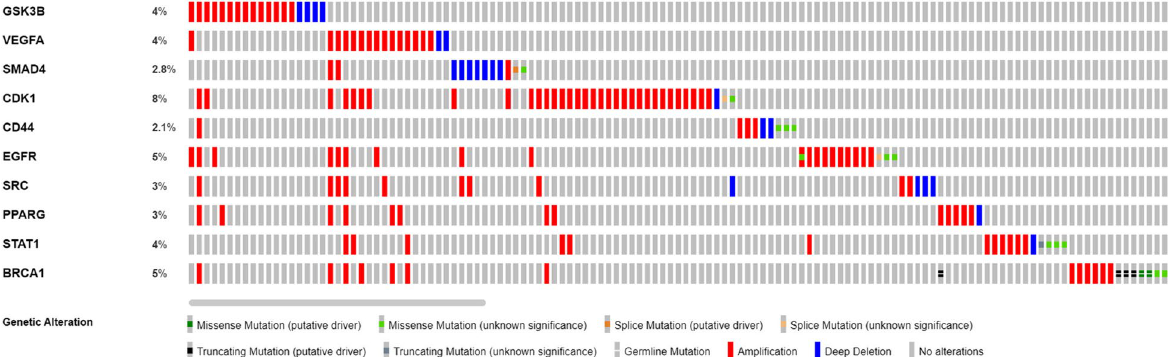
Fig. 5 OncoPrint analysis of the genetic alterations of the hub genes in the metastatic prostate adenocarcinoma study (SU2C/PCF Dream Team, PNAS 2019). Each bar corresponds to a patient’s data while the colour of the bar corresponds to the type of genetic alteration present in the patient. The types of genetic alteration the colours correspond to are present in the